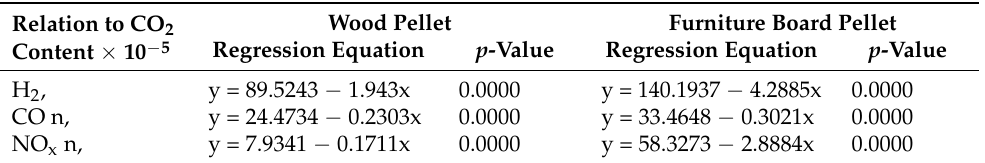
Table 7. Regression equations for the trend line of the dependence of CO, NO x , and H 2 emissions from CO 2 content and p -values. Figure 5. Graphs of CO, NO x , and H 2 content in flue gases (coordinated to CO 2 emission values) in dependence on the Fe 2 O 3 content in pellets: ( a ) Wood pellets (WP); and ( b ) Furniture board pellets (FBP).